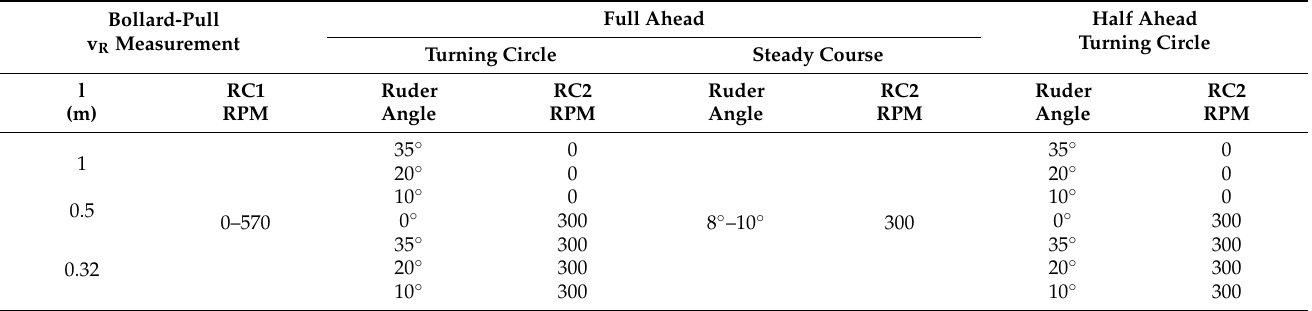
Table 5. Program of model tests. Tests in bollard-pull conditions. Tests at Full Ahead model speed: turning circle and steady course keeping trials. Tests at Half Ahead model speed: turning circle trial.